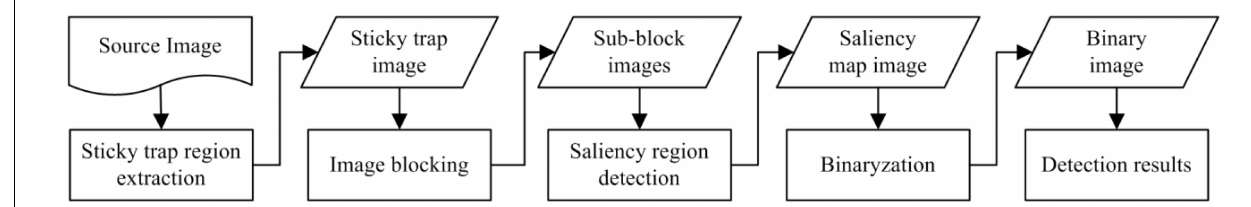
FIGURE 2 | Flow chart of the candidate object location pipeline from source image to detection results.